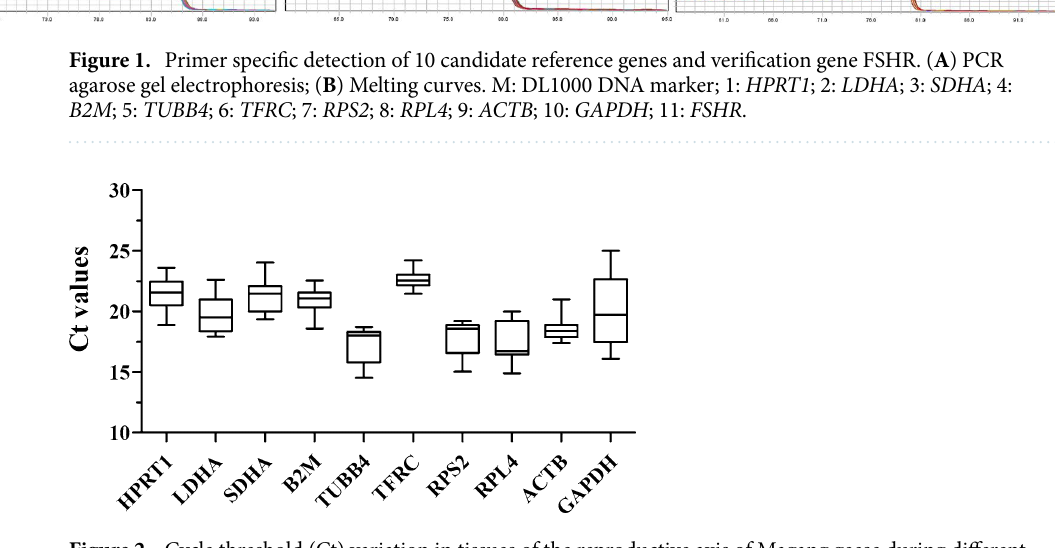
Figure 2. Cycle threshold (Ct) variation in tissues of the reproductive axis of Magang geese during different reproductive